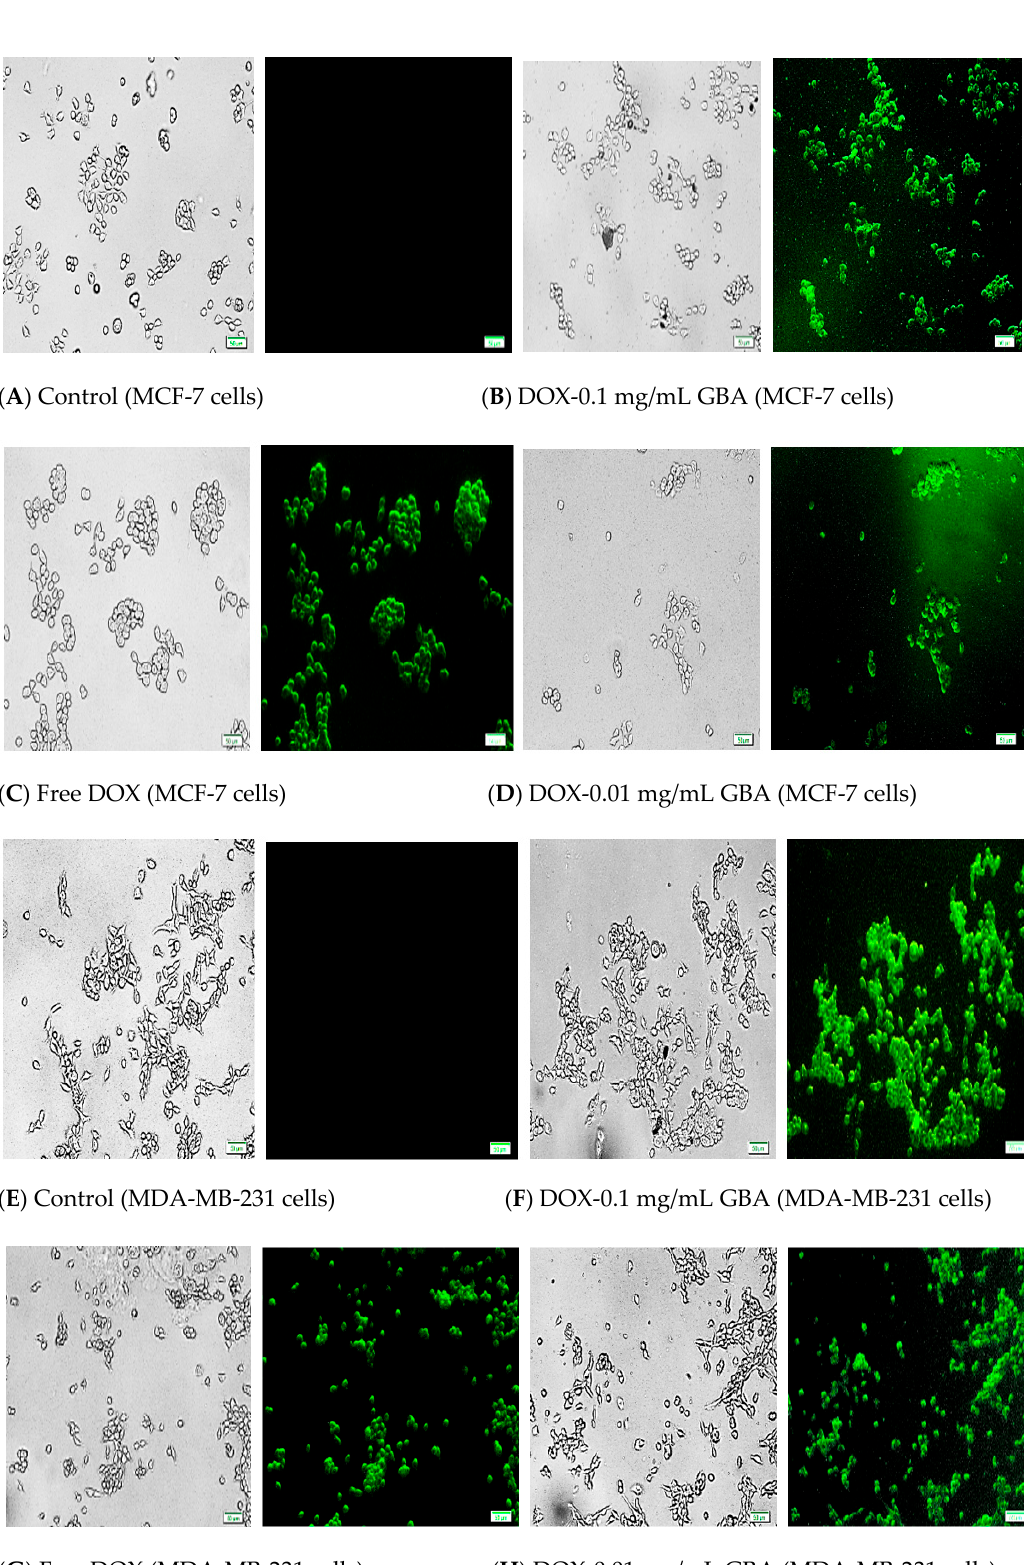
Figure 8. Representative fluorescent images of cellular uptake for ( A ) Control (MCF-7 cells) ( B ) DOX-0.1 mg / mL GBA (MCF-7 cells) ( C ) Free DOX (MCF-7 cells) ( D ) DOX-0.01 mg / mL GBA (MCF-7 cells) ( E ) Control (MDA-MB-231 cells) ( F ) DOX-0.1 mg / mL GBA (MDA-MB-231 cells) ( G ) Free DOX (MDA-MB-231 cells) ( H ) DOX-0.01 mg / mL GBA (MDA-MB-231 cells) following 4 h of